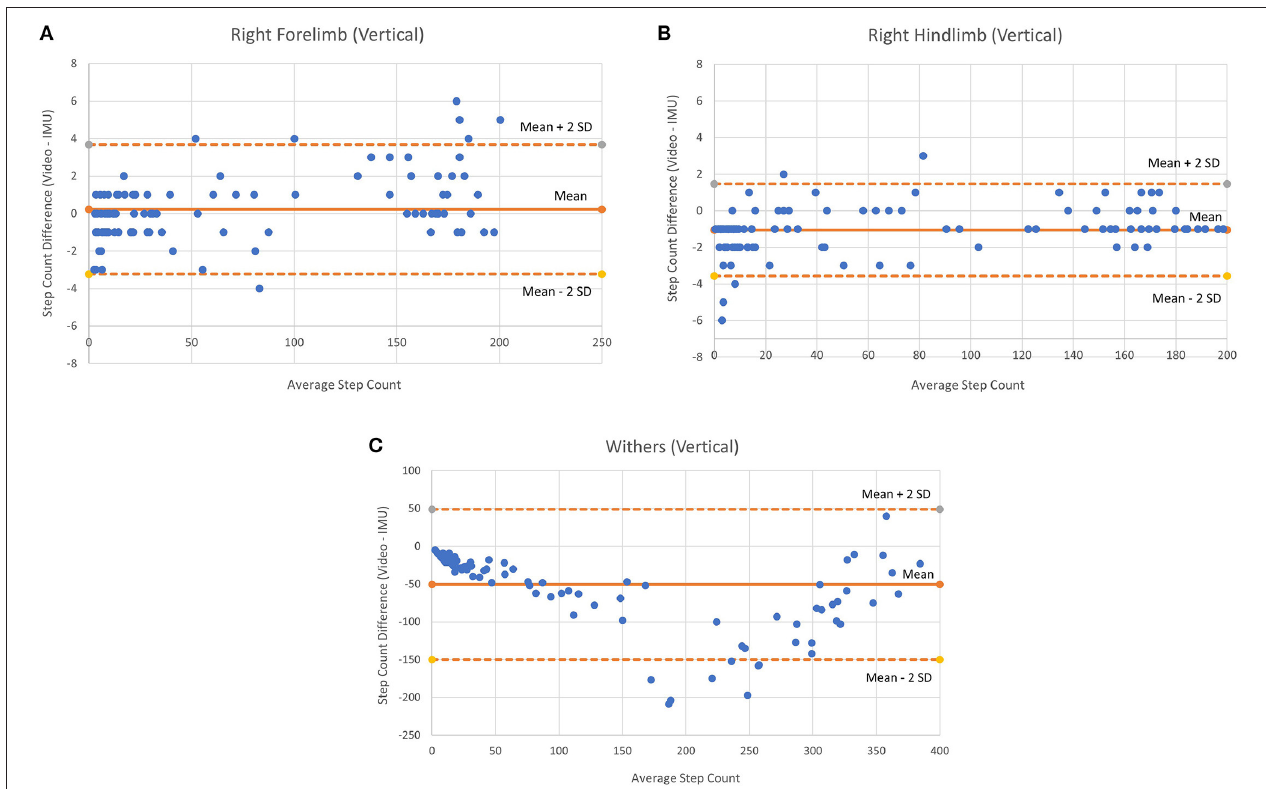
FIGURE 4 | Bland-Altman plots for vertical axes of each sensor location (all movements combined). (A) Right Forelimb, (B) Right hindlimb, and (C) Withers.